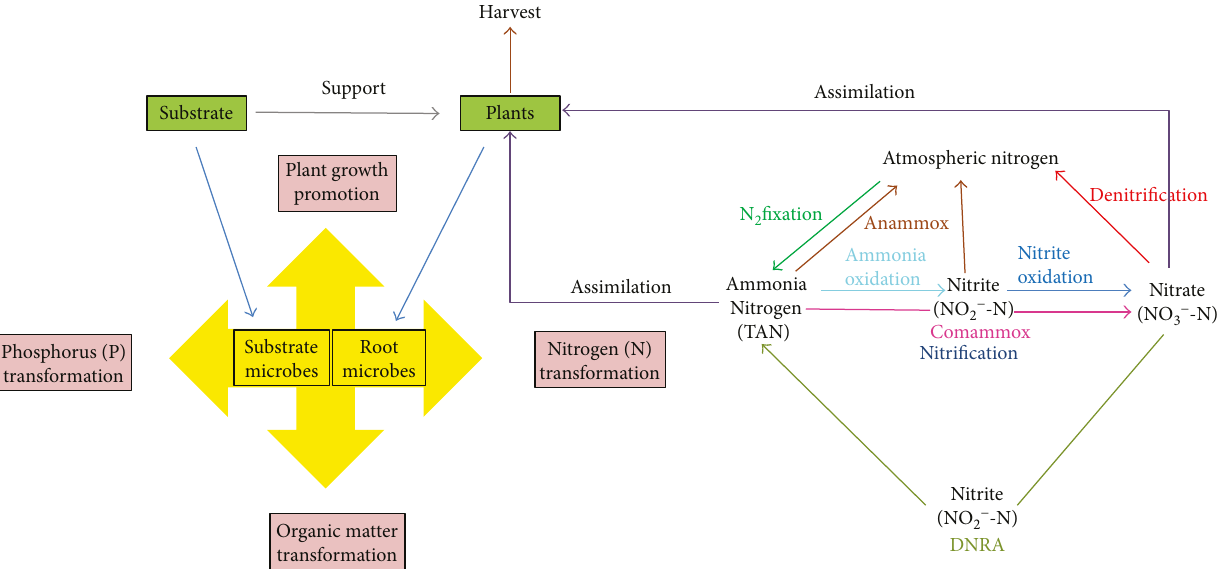
Figure 5: Key processes of recirculating CWs involved in the removal of various pollutants, especially marine